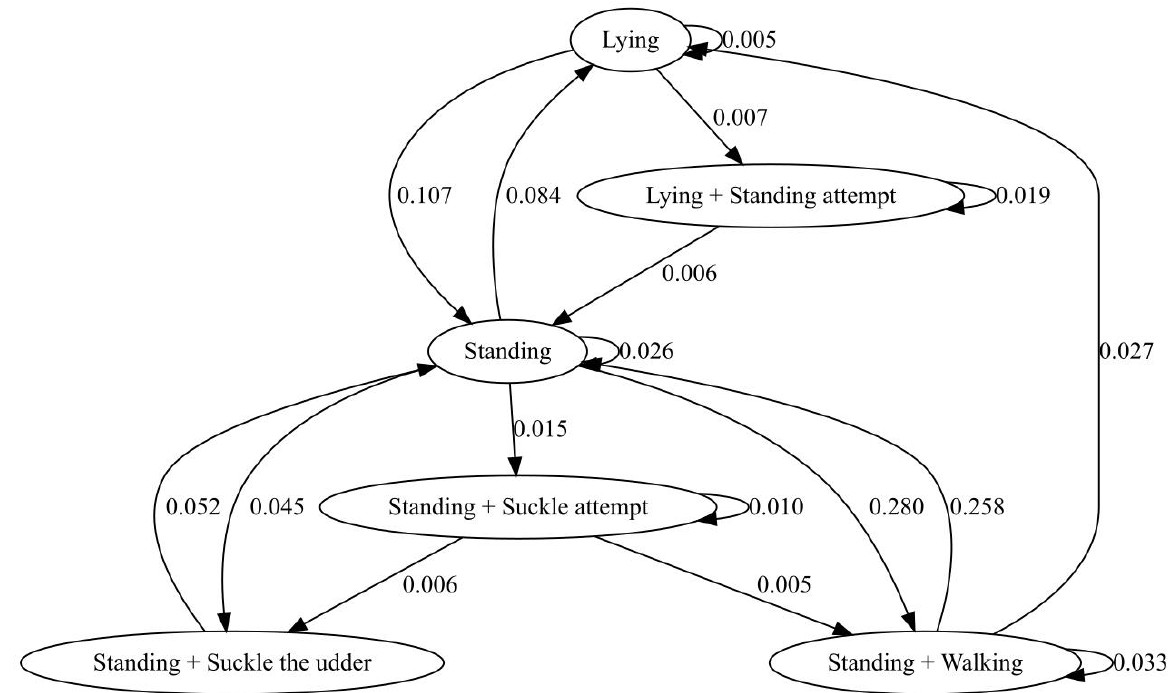
Figure 1. Transition flow diagram of the calves’ behaviours in the first 48 h after birth. The values represent the frequency of the transitions between the different behaviours. The diagram was obtained from the transition matrix exported from BORIS selecting the following behaviours: lying, standing, standing attempt, suckling attempt, walking, and suckling the udder. The final diagram was obtained from Graphviz, selecting the behaviours with a frequency of transition higher than 0.005.